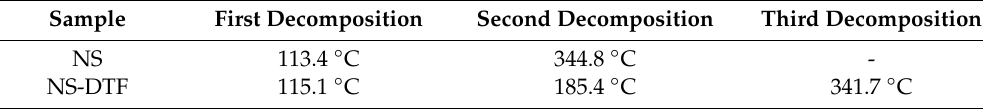
Table 2. Decomposition temperatures of NS and the NS-DTF complex.